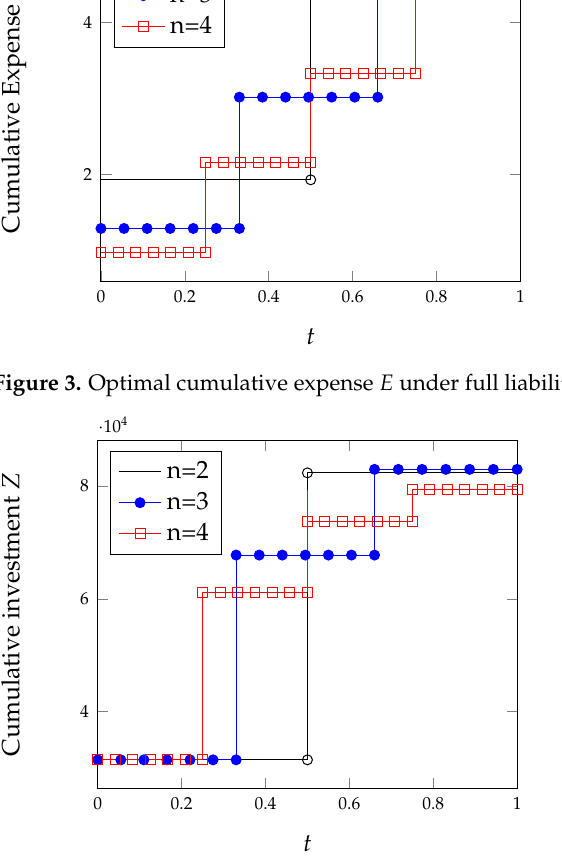
Figure 4. Optimal cumulative investment under partial liability and GL1